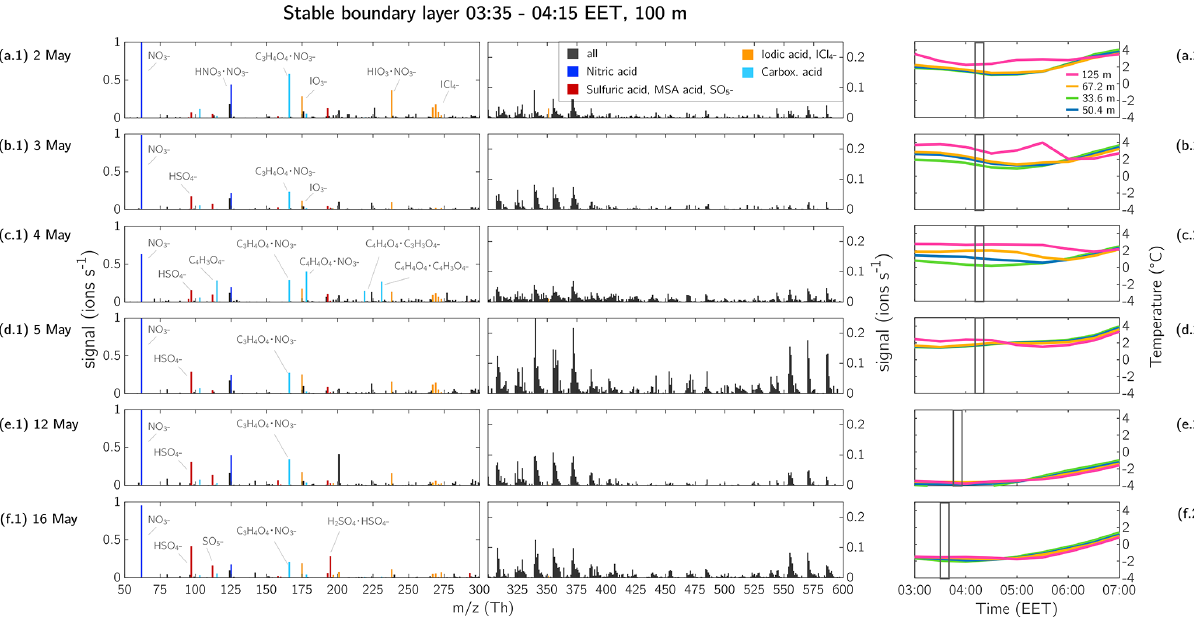
Figure 11. Measurements from 100m above the ground during early morning between 03:45 and 04:15EET. Ion spectra measured with APi-TOF (a.1–f.1) . The mass axis is split at 300Th such that the limits of the vertical axis could be decreased to make the ions > 300Th more visible. The composition of identified ions with a high signal are noted in the figure. Please note that unlike in Figs. 6, 7, and 10, the signal > 300Th is not coloured green. The majority of the compounds is HOM dominated, but other ions are also abundant and to avoid possible false colour coding in this higher-resolution figure, the colour is kept neutral. Panels (a.2–f.2) show the temperature profile measured at SMEAR II station at the following four levels: 33.6, 50.4, 67.2, and 125m. The grey box indicates the measurement time of the ions in panels (a.1) – (f.1) .